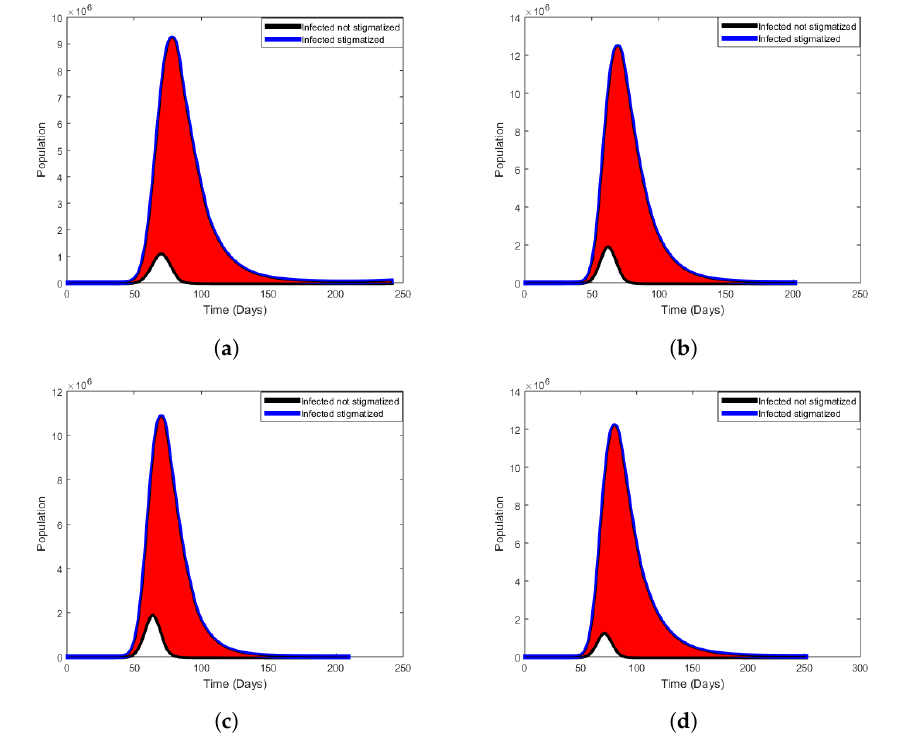
Figure 10. High regime state. ( a ) Wave 1. ( b ) Wave 2. ( c ) Wave 3. ( d ) Wave